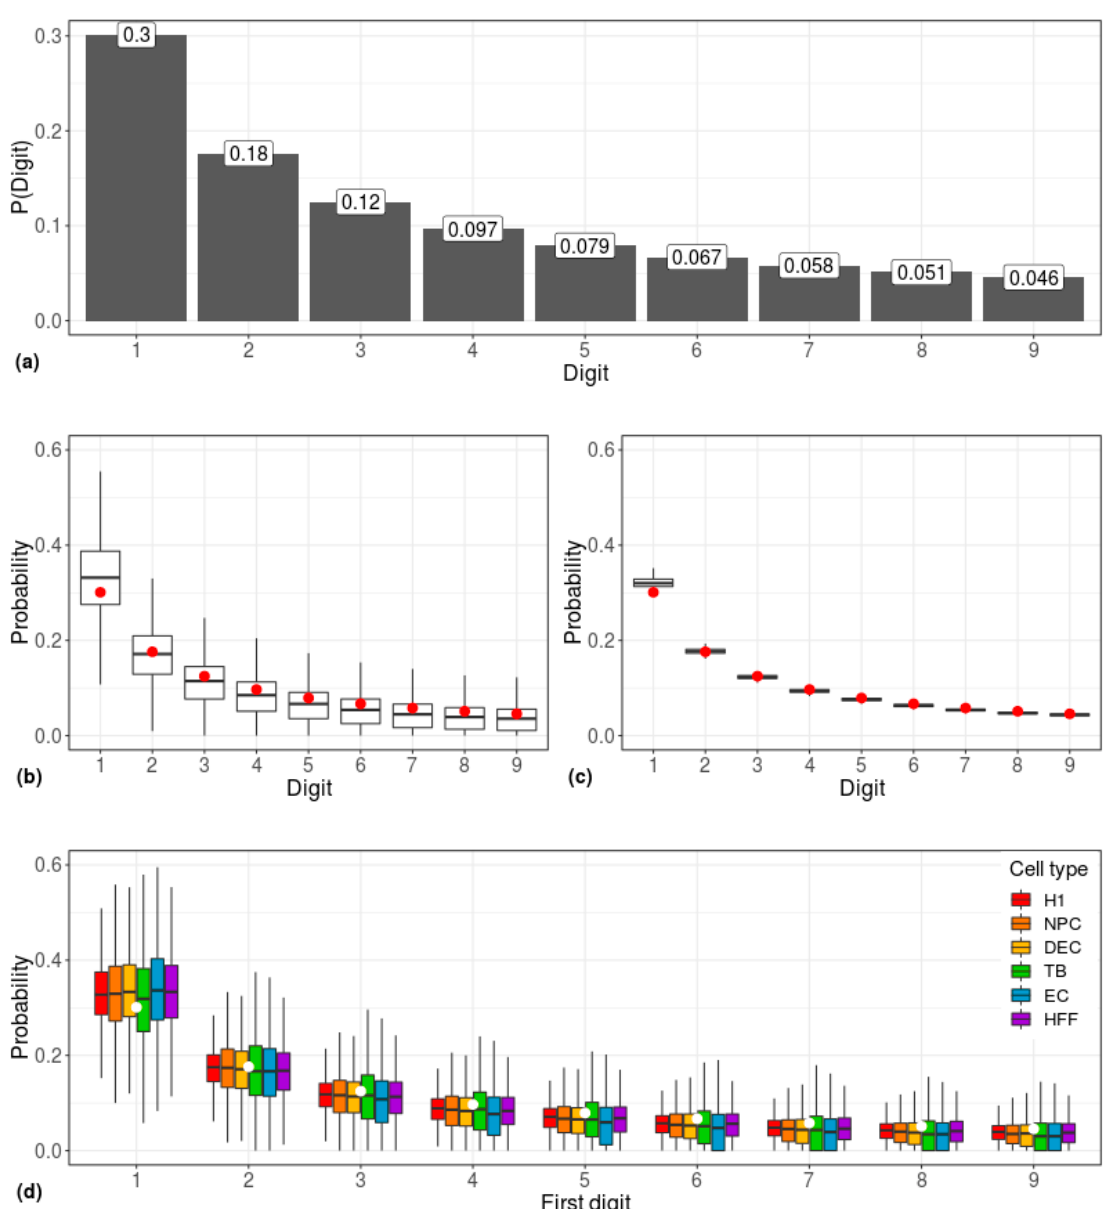
Figure 1. Correlations between scRNA-seq data and the Benford distribution. ( a ) Predicted prevalence of the occurrence of each leading digit according to the Benford Law. D = digit; P(Digit) = Frequency of D. ( b ) Gene-centered and ( c ) cell-centered first-digit distributions, calculated across 1,018 single cells. The predicted Benford distribution is represented by red dots. ( d ) First-digit distribution of gene-centeredexpressiondataofsixcelltypes. WhitecirclesrepresentthepredictedBenforddistribution. H1: human embryonic stem cells ( n = 375 cells); NPC: neural progenitor cells ( n = 173 cells); DEP: definitive endoderm progenitors ( n = 138 cells); EC: endothelial cells ( n = 105 cells); TB: trophoblasts ( n = 69 cells); HFF: human foreskin fibroblasts ( n = 159 cells)